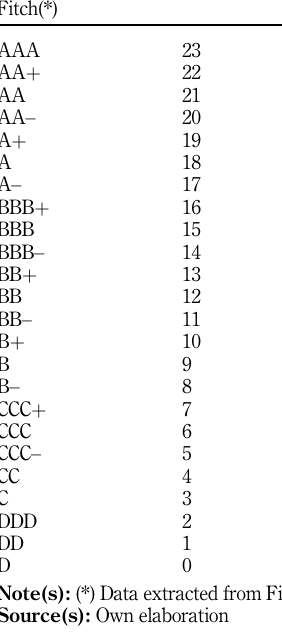
transformed digital form of the